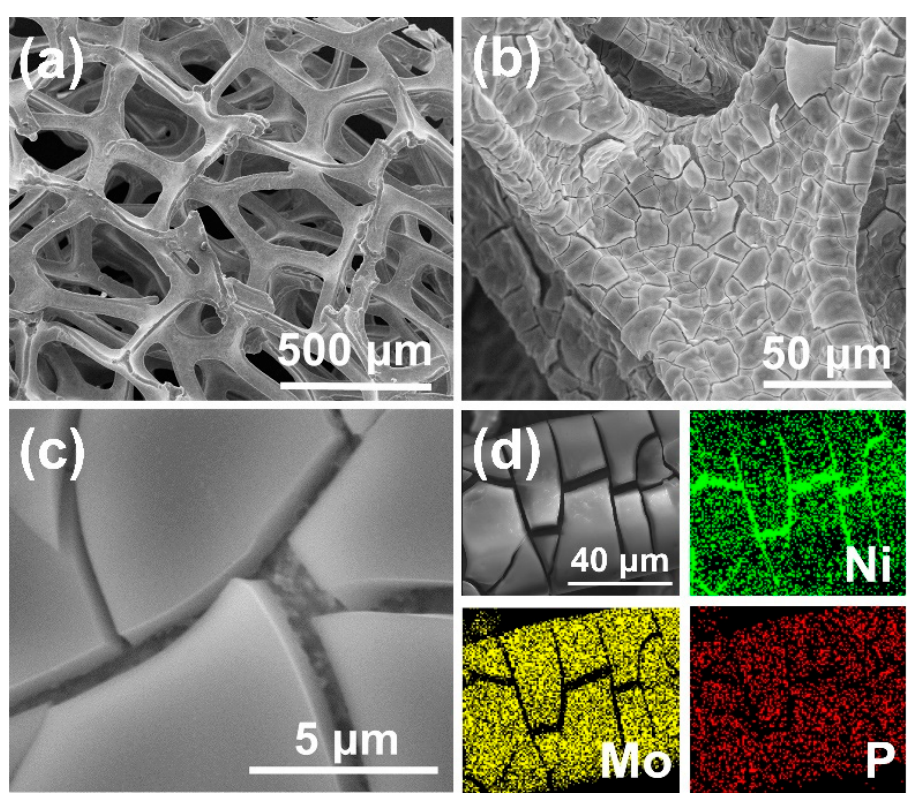
Figure 1. ( a – c ) SEM images of NiMoP/NF; ( d ) EDS elemental mapping images of NiMoP/NF. X-ray diffraction (XRD) tests were carried out to study the phase structure of the samples. The XRD patterns of NF, Ni(OH) 2 /NF, NiP/NF, and NiMoP/NF exhibit three diffraction peaks at 44.8 ◦ , 52.1 ◦ , and 76.6 ◦ (Figure S5a), corresponding to the (111), (200), and (220) crystallographic planes of nickel [16]. The local magnification of the Ni(OH) 2 /NF XRD pattern reveals that characteristic peaks could be matched with JPCDS No. 14-01117 (Figure S5b). The Ni(OH) 2 phase is further confirmed by the classical lamellar structure of hydroxide depicted in a SEM image (Figure S3b) [17]. Consistent with the XRD results of the film structure prepared by one-step electrodeposition in other studies, wide diffrac- tion peaks centered at around 21.5 ◦ (Figure S5c) and 22.0 ◦ (Figure S5d) can be seen in XRD patterns of NiP/NF and NiMoP/NF, implying the amorphous properties of the two electrodeposited films [15,16,18]. The electrodeposited NiMoP film on an NF surface was then studied by high-resolution transmission electron microscopy (HRTEM). In magnified HRTEM images with a 2–20 nm scale bar (Figure 2a–c), no ordered lattice fringe can be found, while there is no lattice diffraction ring in the selected area electron diffraction (SAED) pattern (inset in Figure 2c). These findings are in line with the XRD results, imply- ing the amorphous structure of NiMoP coating [19,20]. In addition, the results of energy dispersive X-ray spectroscopy attached to TEM (TEM–EDS) show that the Ni, Mo, and P elements are evenly distributed across the entire region of the sample (Figure 2d), echoing with the elemental distribution result based on the SEM–EDS